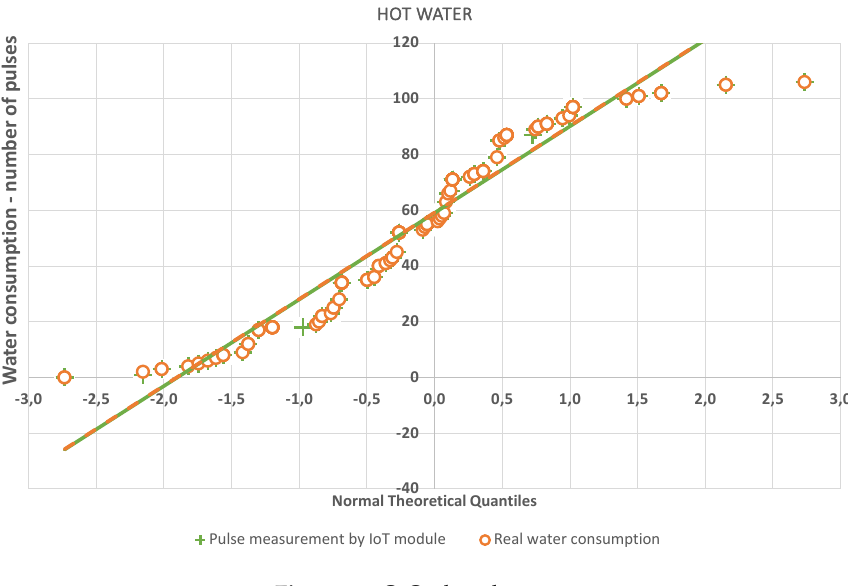
Figure 16. Q-Q plot—hot water.